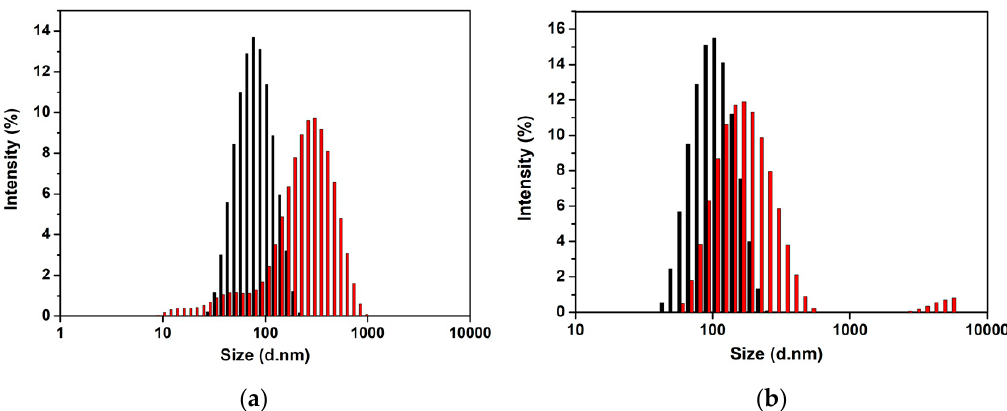
Figure 1. Intensity size distributions of SLNs prepared with a PGMP:GMS mass ratio of 2:1 ( a ) or 1:1 ( b ) and a carvacrol loading at 30% mass of lipids, before (black column) and after (red column) 30-day storage at 25 °C.